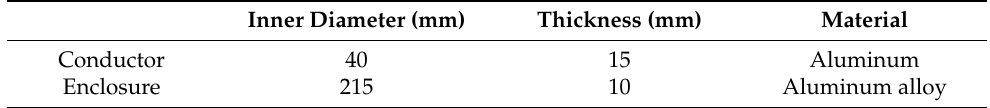
Table 1. Parameters of the simulation model.